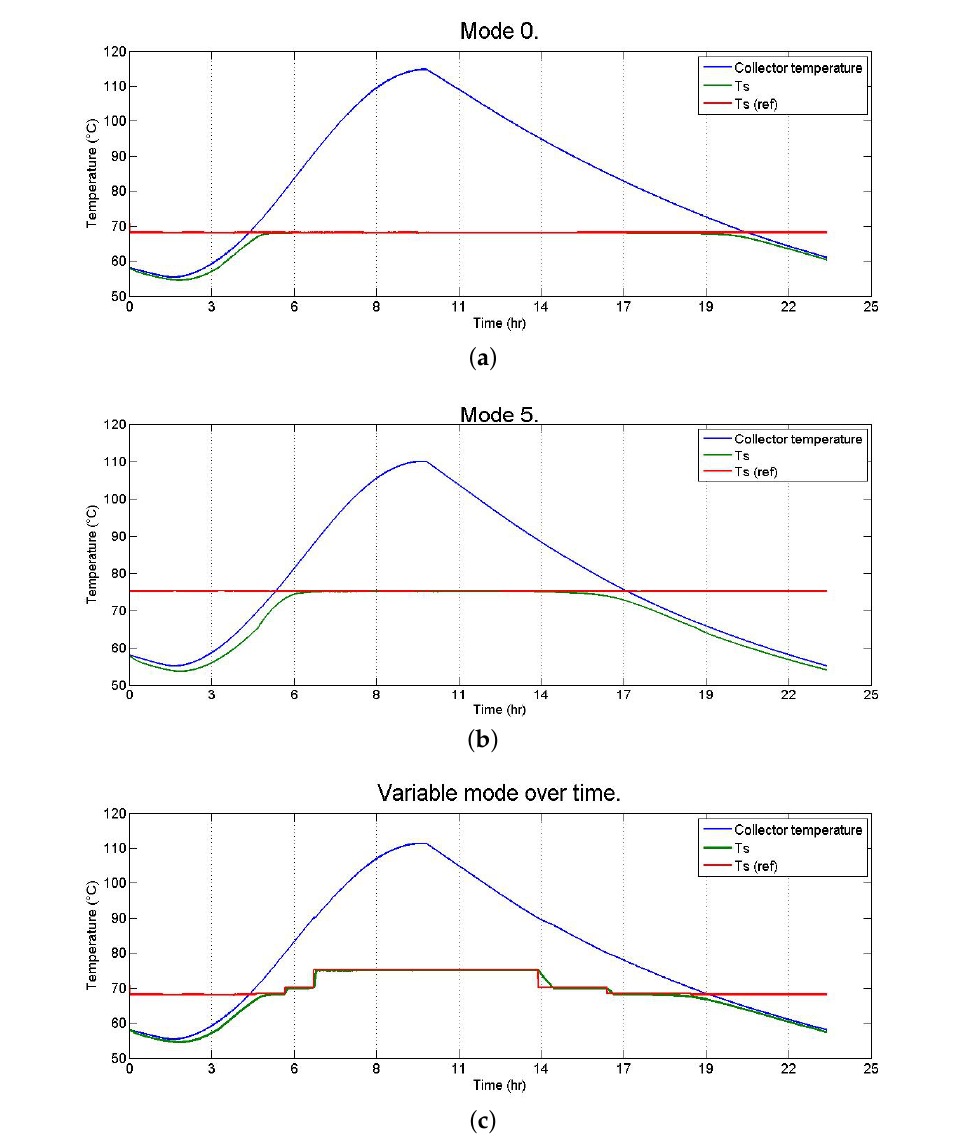
Figure 14. In the numerical simulation, blue lines represent the collector temperature, green solid lines the response of temperature for storage tank and red solid lines the temperature reference. ( a , b ) Temperature reference is constant; ( c ) different mode changes applied over time.